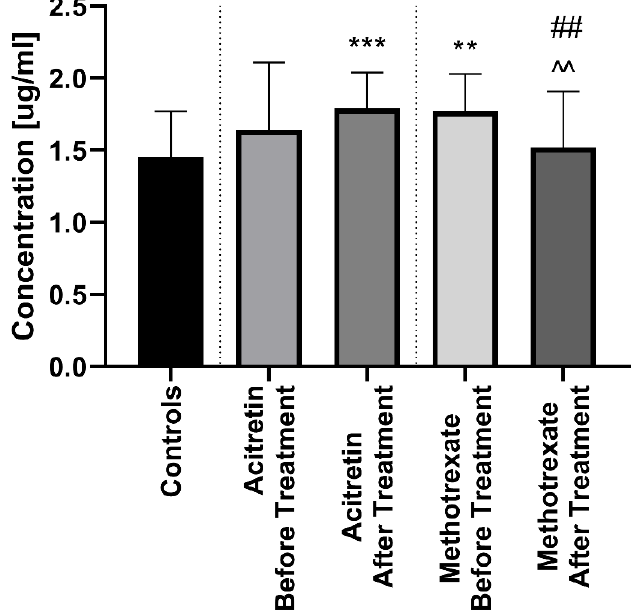
Figure 4. Comparison between PCSK9 concentations before and after treatment with acitretin and methotrexate separetely in psoriatic patients and controls. ** / *** means statistical significance with p < 0.01 / 0.0001 respectively compared to Controls. ## means statistical significance with p < 0.01 between acitretin after treatment compared to methotrexate after treatment. ˆˆ means statistical